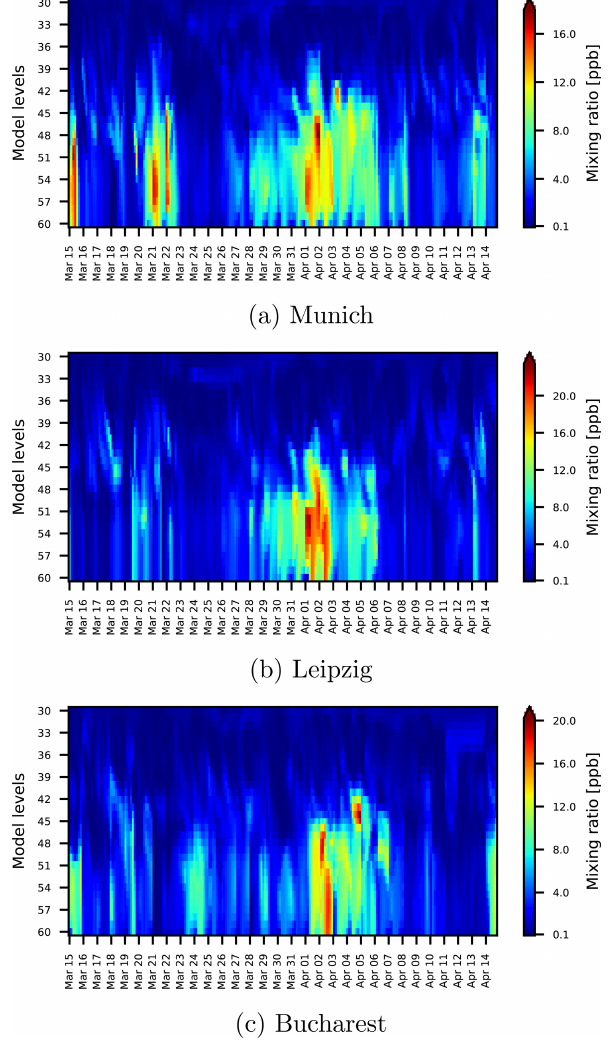
Figure 3. Time series of CAMS mixing ratios for sulfate for Mu- nich (a) , Leipzig (b) , and Bucharest (c) , 15 March–14 April 2014.